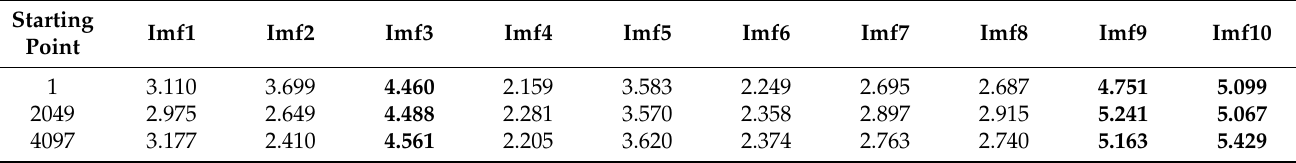
Table 3. The kurtosis value of each mode of the outer ring fault.